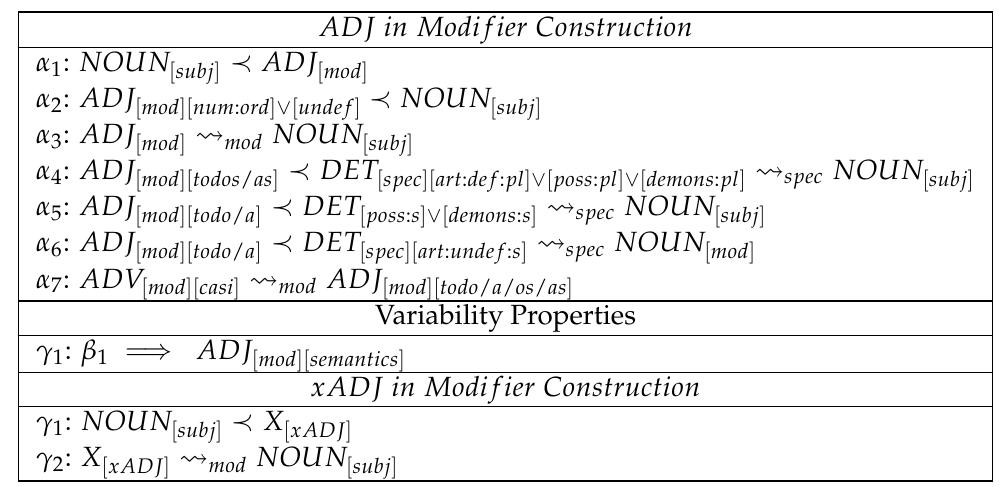
Table A2. Spanish properties of ADJ in modifier construction.